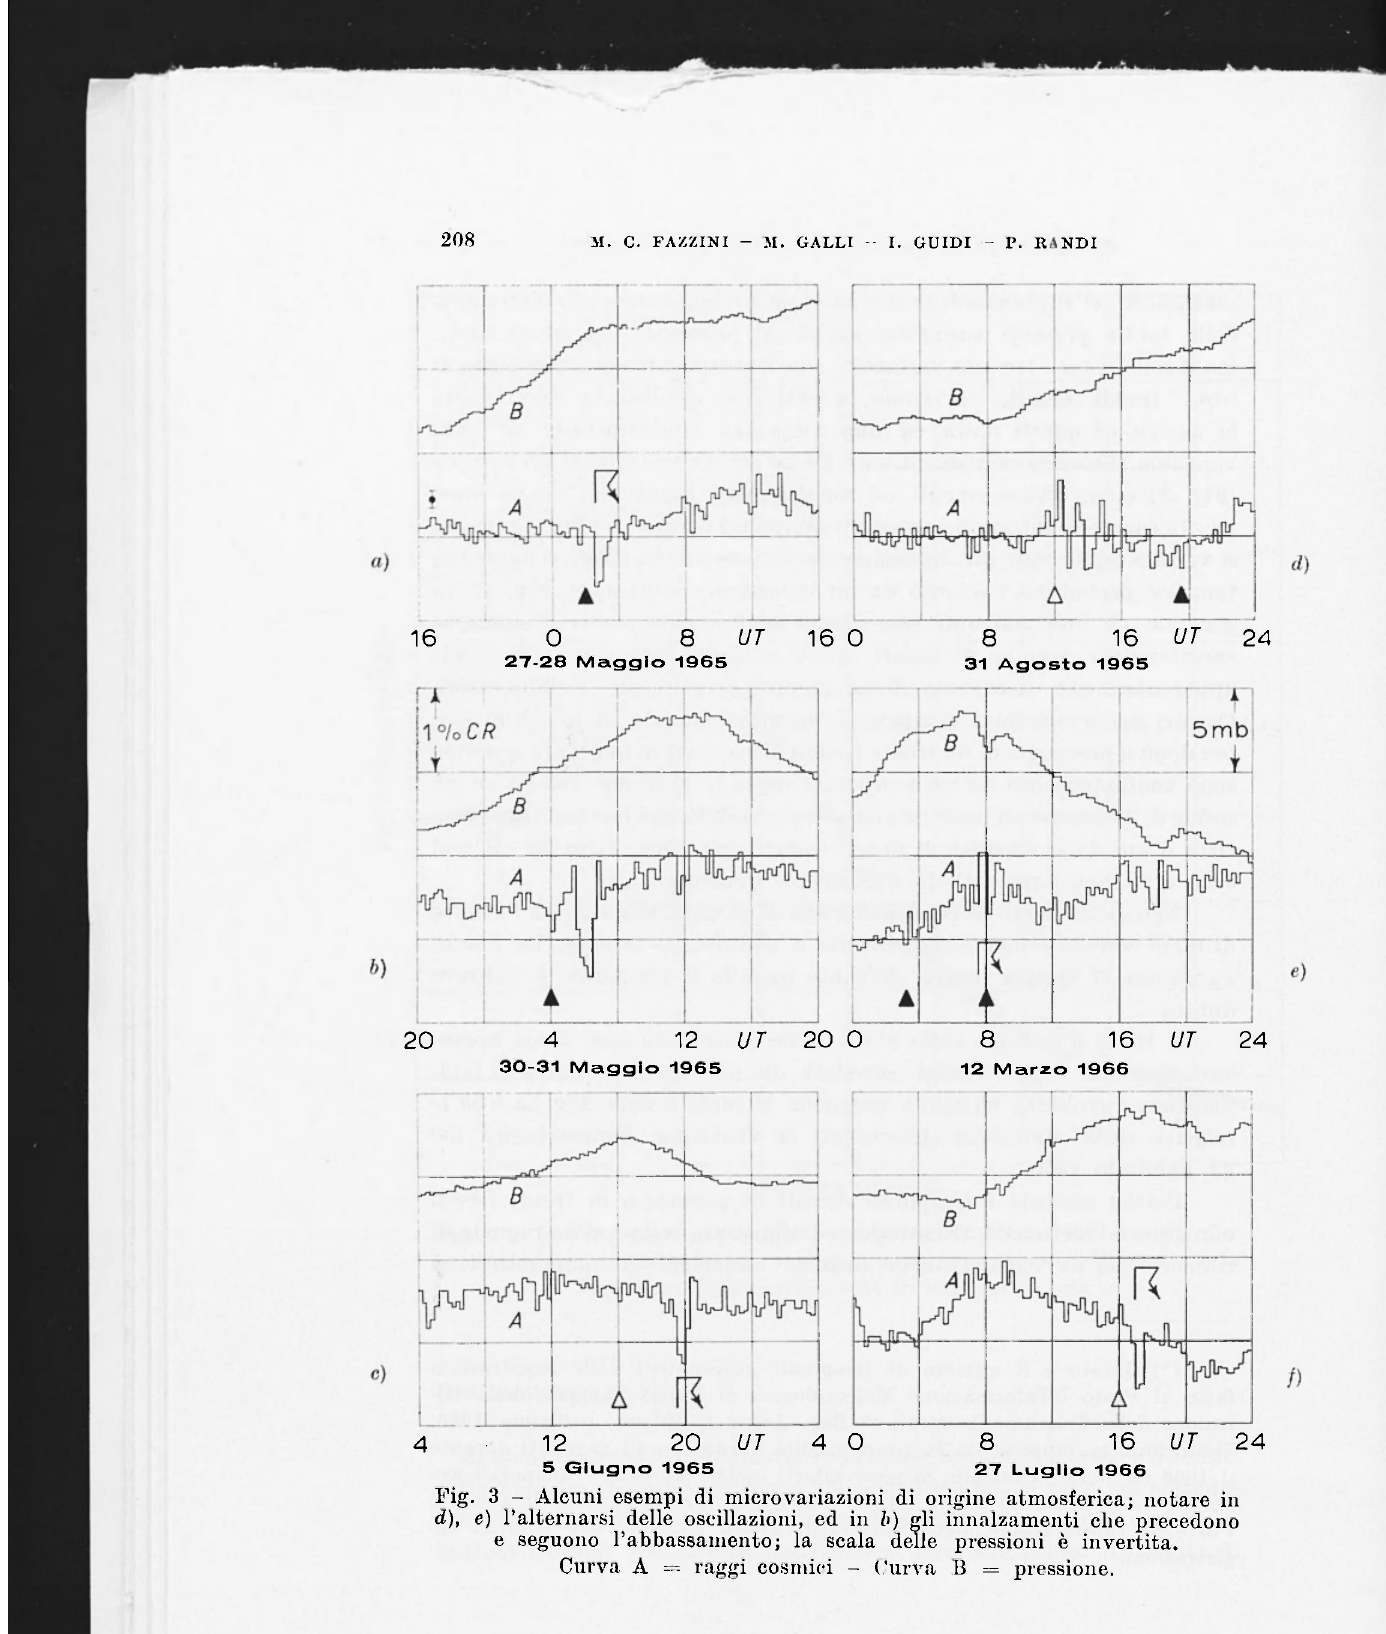
Fig. 3 - Alcuni esempi di microvariazioni di origine atmosferica; notare in d), e) l'alternarsi delle oscillazioni, ed in b) gli innalzamenti clie precedono e seguono l'abbassamento; la scala delle pressioni è invertita. Curva A = raggi cosmici - Curva B =